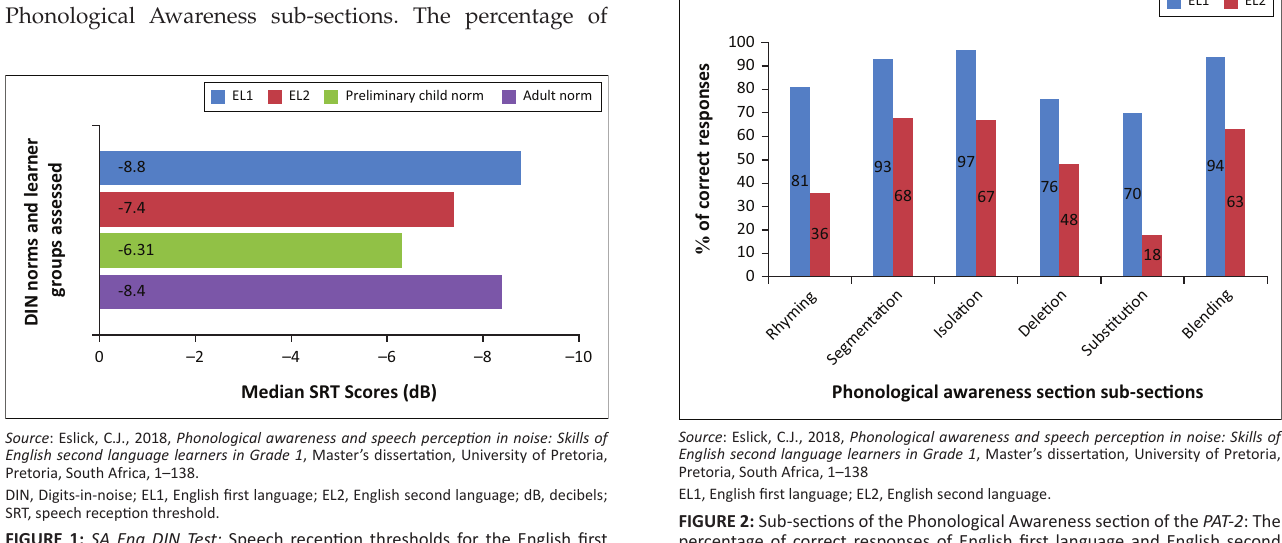
FIGURE 2: Sub-sections of the Phonological Awareness section of the PAT-2 : The percentage of correct responses of English first language and English second language